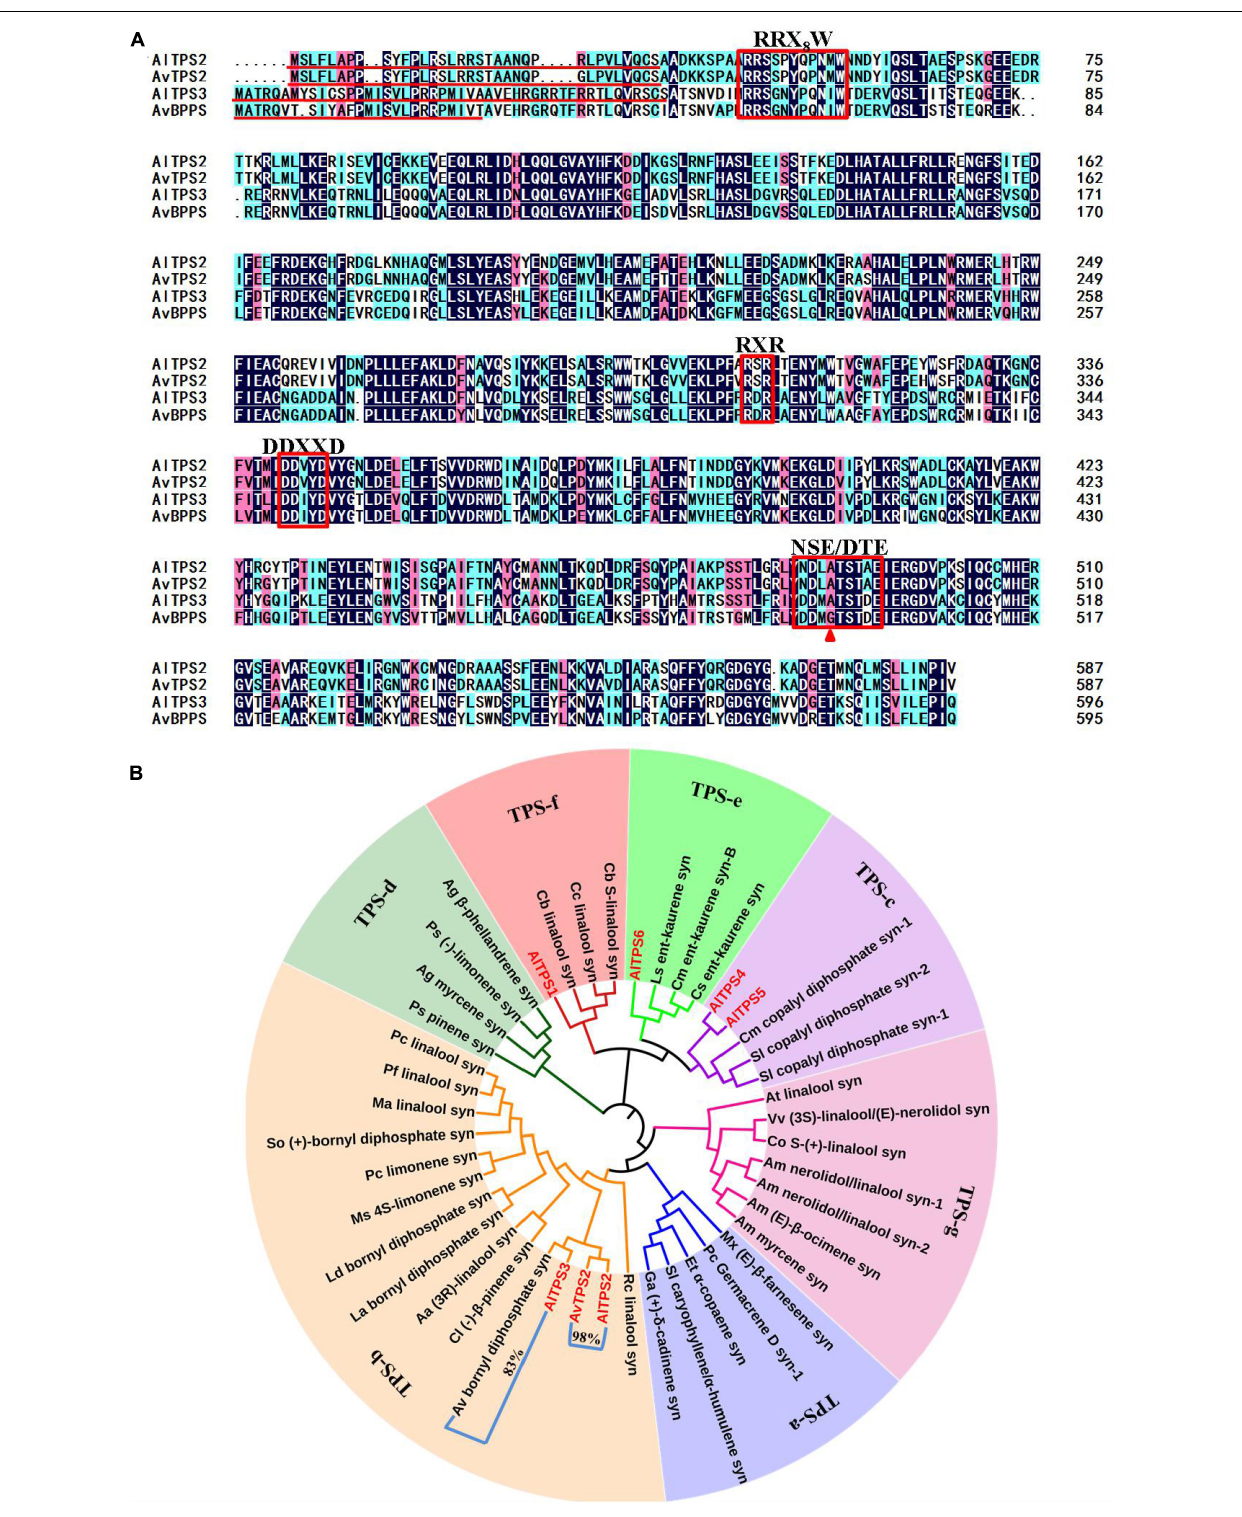
FIGURE 2 | Amino acid sequence alignment of AlTPS2, AlTPS3, AvTPS2 and AvBPPS (A) and phylogenetic analysis of AlTPSs from A. longiligulare , AvTPS2 and terpenoid synthases from other plants (B) . The red underline indicates the plastid transport peptide. The red box represents the conserved motifs. The red triangle indicates the different amino acids between AlTPS3 and AvBPPS. The number in (B) represents the identity of the amino acid sequences of two genes clustered into one branch.